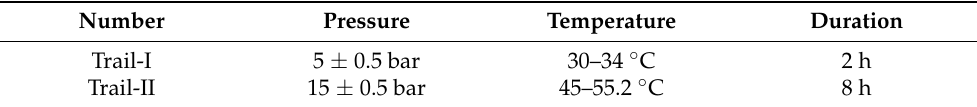
Figure 9. 3D-printed and injection-molded samples autoclave arrangement. Table 2. Showing trails and parameters of autoclave pressurization with temperature of PLA samples, both injection-molded and